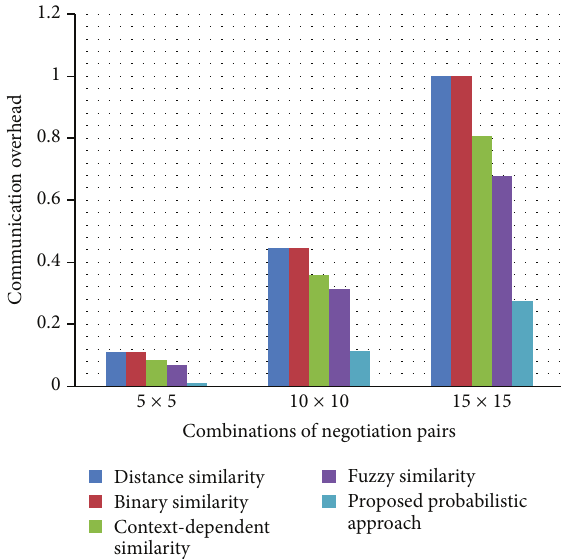
Figure 6: Achievement of communication overhead optimality.